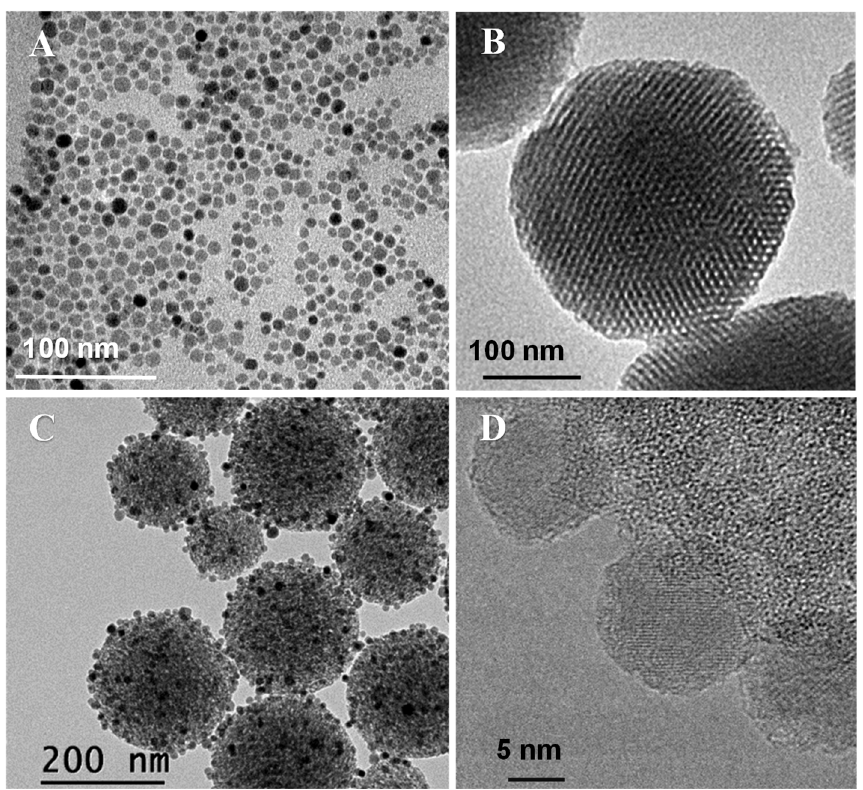
Figure 2. TEM images of OA-Fe 3 O 4 NPs ( A ), bare MSNs ( B ), mMSN f -PEG-PNIPAM nanosystem ( C ) and HRTEM image of mMSN f -PEG-PNIPAM ( D ).